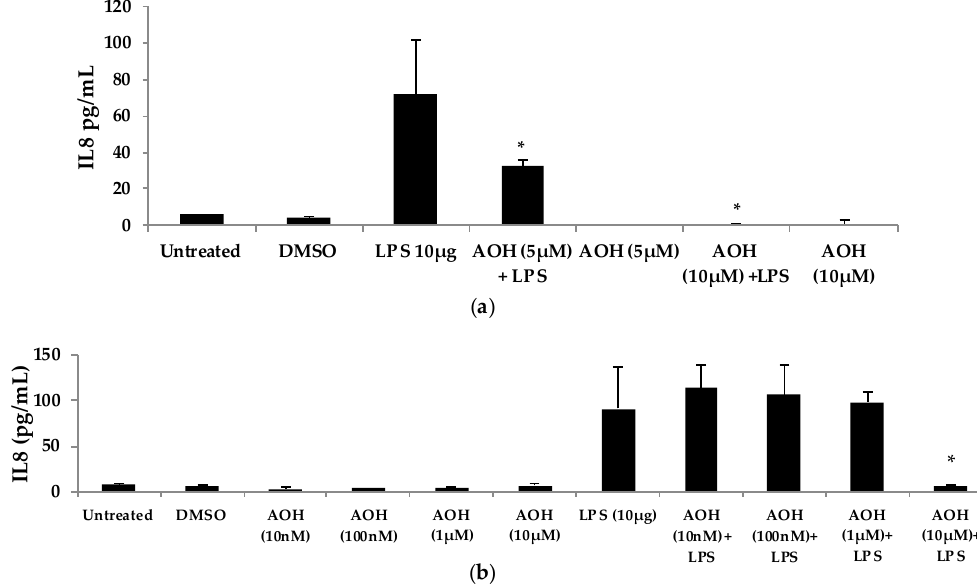
Figure 4. Dose-dependent response of airway epithelium cells (BEAS-2B) after treatment with alternariol (AOH) and lipopolysaccharide (LPS). ( a ) BEAS-2B cells were treated with (5–10 μ M) of AOH in the presence and absence of 10 μ g of LPS to measure IL8 levels released. Cell densities were 5 × 10 5 cells/well and were incubated for 24 h under normal conditions at 37 °C, 5% CO 2 after treatment; ( b ) BEAS-2B cells were treated with (10 nM–10 μ M) of AOH in the presence and absence of 10 μ g of LPS to measure IL8 levels released in supernatants using enzyme-linked immunosorbent assay (ELISA). Cell densities were 5 × 10 5 cells/well and were incubated for 24 h under normal conditions at 37 °C, 5% CO 2 after treatment. An * indicates p < 0.05 according to Student’s t -test when comparing AOH + LPS treatments to LPS-induced control.